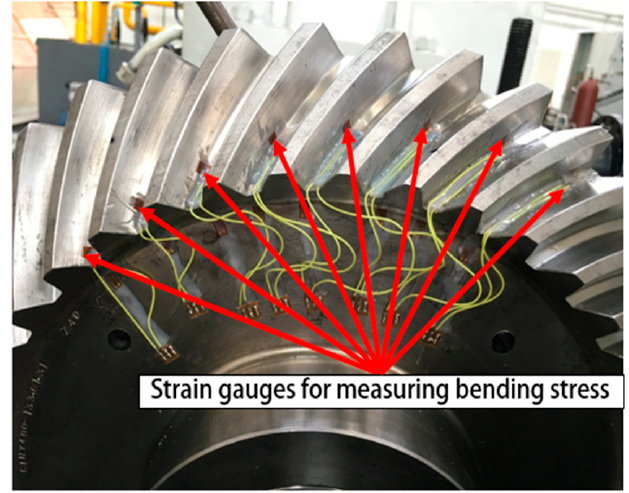
Figure 17. Layout of root strain gauges.